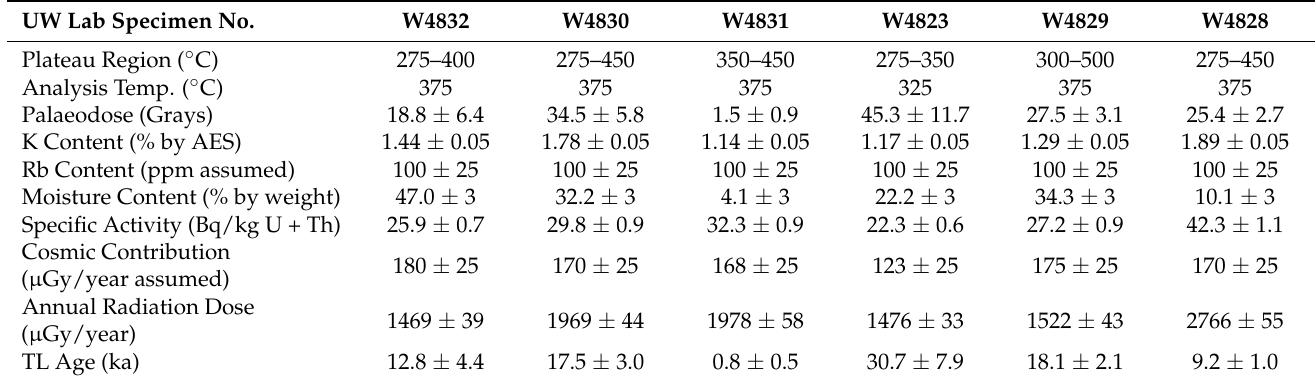
Table A1. Laboratory results provided by David M. Price, Thermoluminescence Laboratory, University of Wollongong, Australia for TL samples from Mickey Springs, Alvord Valley, Oregon. UW Lab Specimen